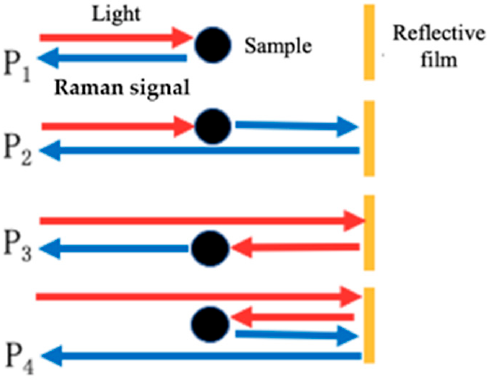
Figure 6. Raman signal transmission diagram in the capillary with an inserted reflector.